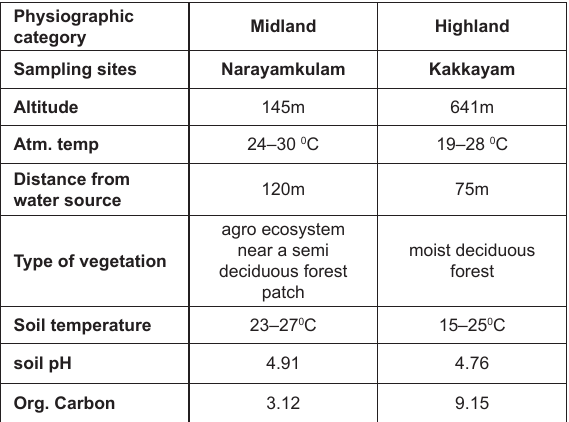
Table 1. Ecological observations from the sampling sites Physiographic